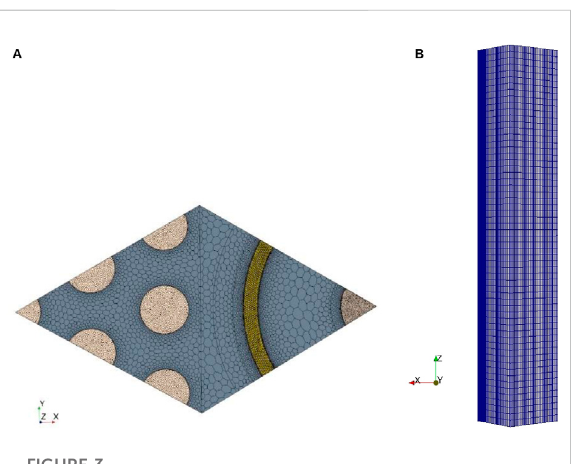
FIGURE 3 Mesh grids layout. (A) radial perspective. (B) axial perspective.